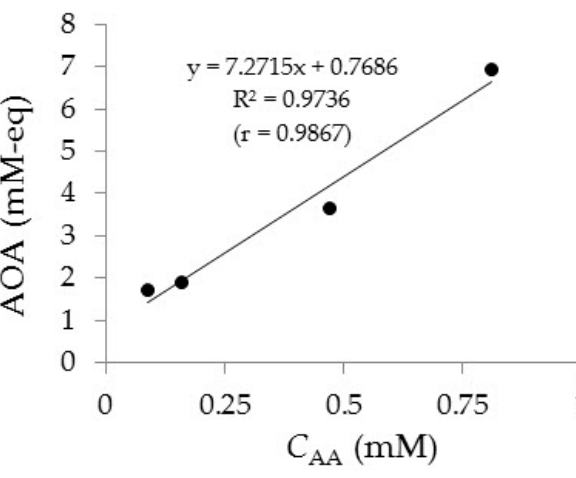
Figure 10. Correlation between AA content and AOA value of fruit juices.